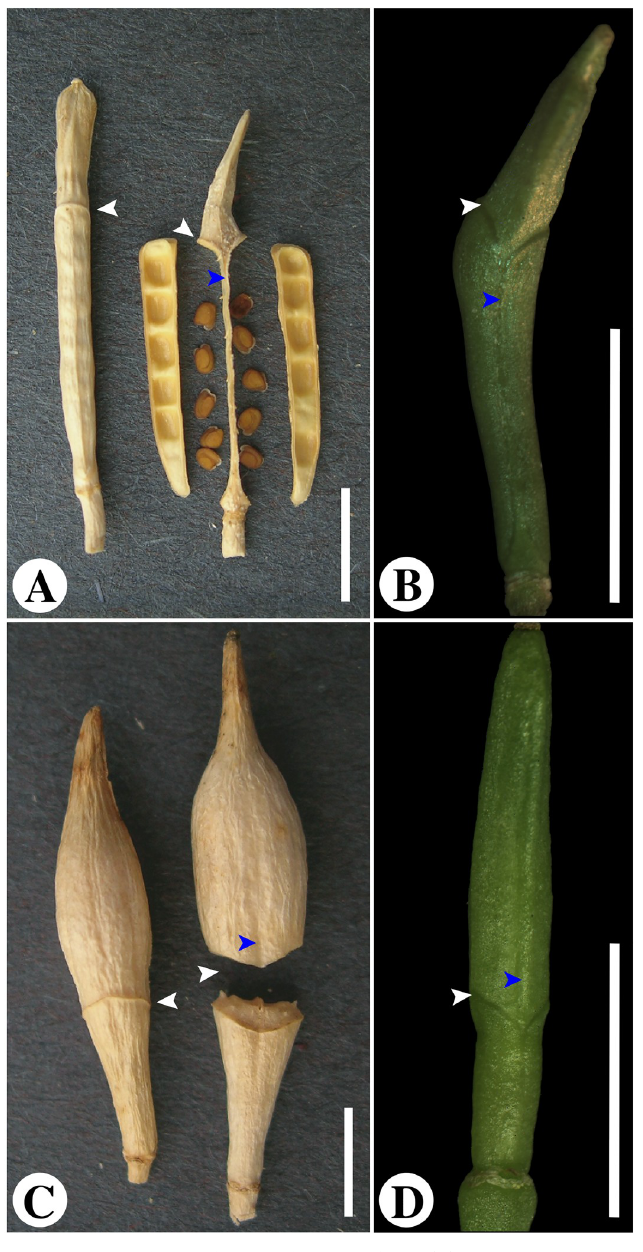
Fig 2. Mature and young heteroarthrocarpic fruits. (A), Mature Erucaria erucarioides fruit in lateral view before dehiscence (left), and medial view after dehiscence (right). (B), Young E . erucarioides fruit representing size sampled for transcriptomics in medial view. C, Cakile lanceolata fruit in lateral view before joint abscission (left), and medial view after joint abscission (right). (D), Young C . lanceolata fruit representing size sampled for transcriptomics in medial view; Modified from Fig 1 [34]. White arrows indicate joint region; blue arrows indicate replum. Scale bars =